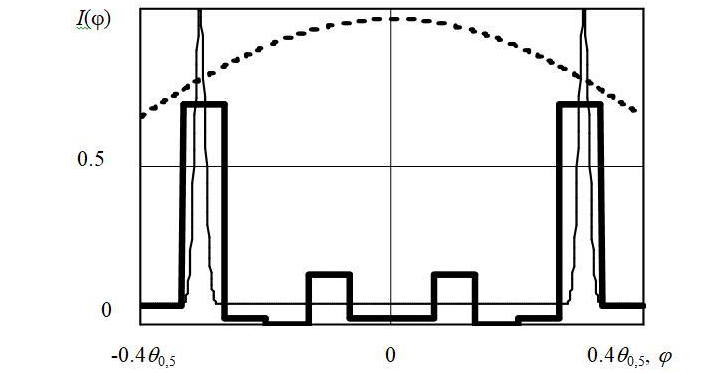
Fig. 1. The reconstructed image of a complex object.